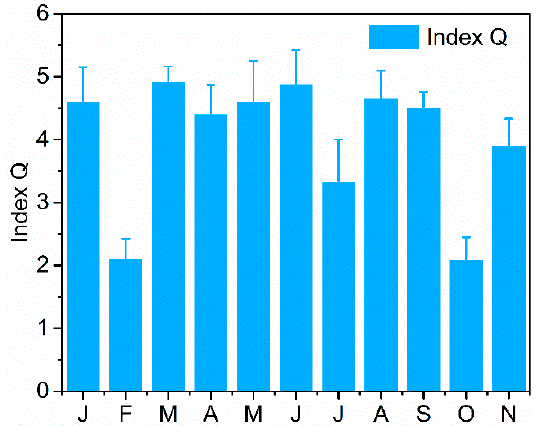
Figure 7. Ecological status assessment according to the Q index with standard deviation in the Reservoir in 2014.